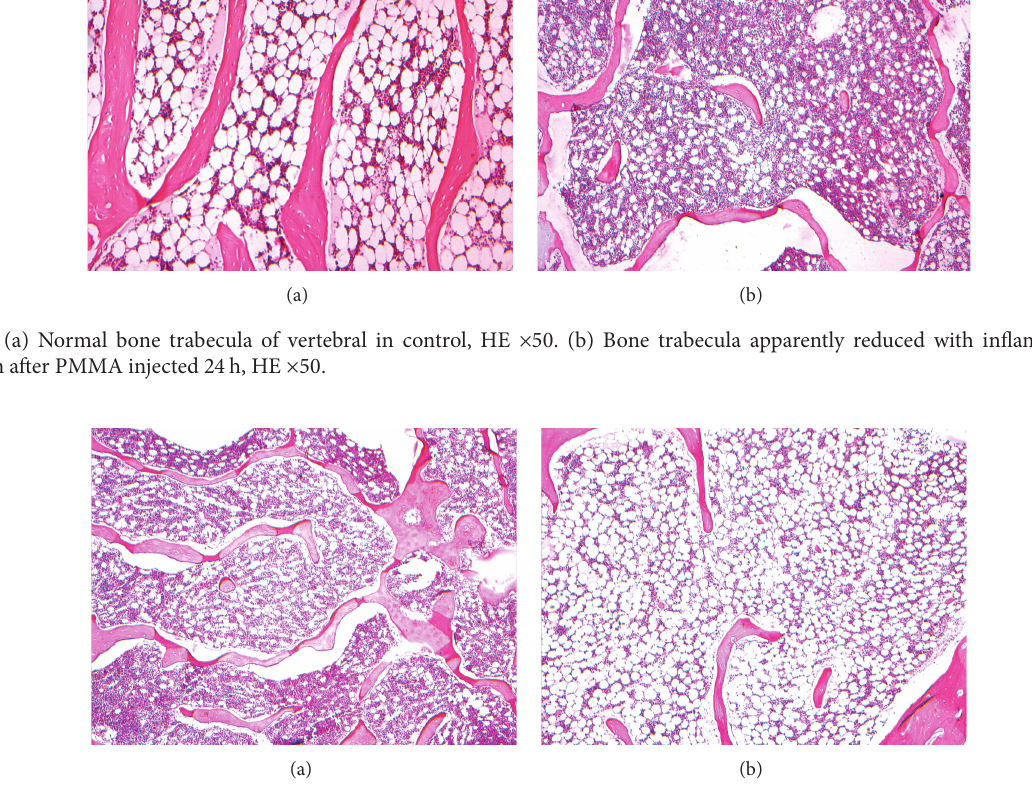
Figure 2: (a) Inflammatory cells infiltration after PMMA injected 3d, HE × 50. (b) Inflammatory reaction lightened after PMMA injected 7d, HE ×